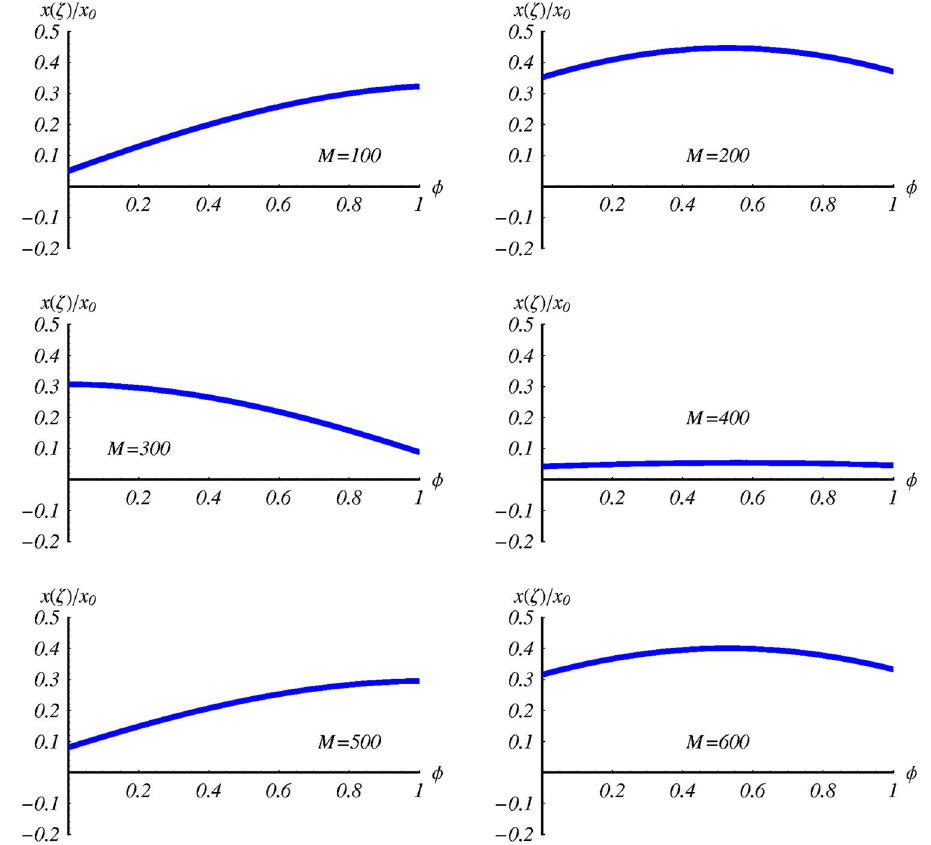
FIG. 7. (Color) Bunch shapes in a train of finite-length bunches. The parameters are the same as in Fig.